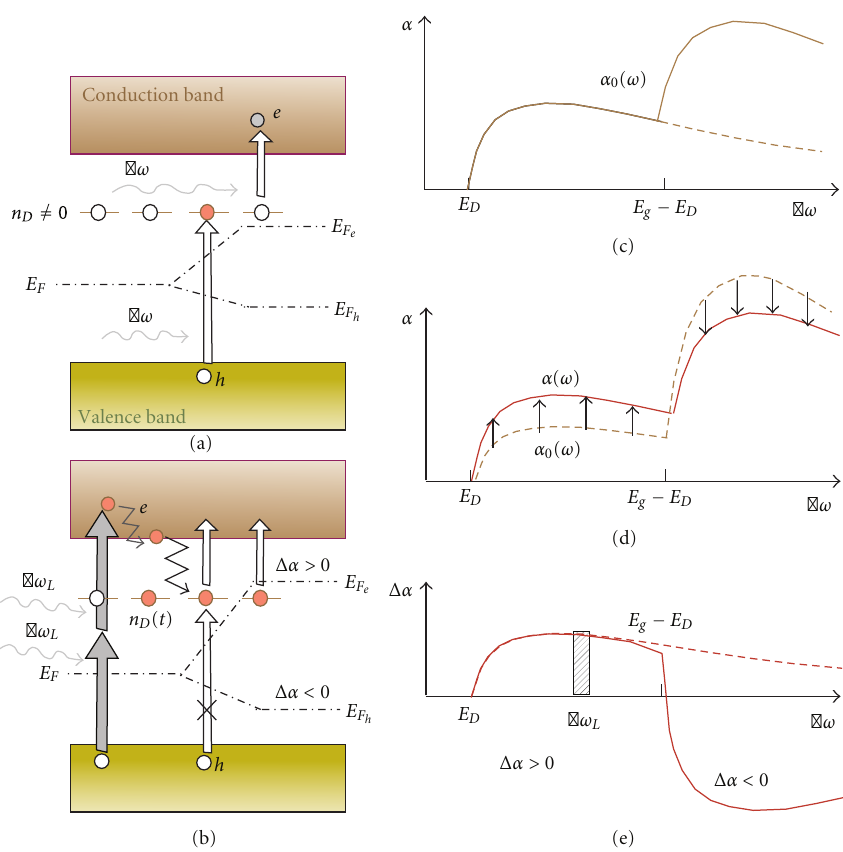
Figure 9: Schemes of the spectra formation for stationary α ( ω ) and induced Δ α ( ω ) impurity absorption and the optical transitions, explaining γ -DLSS, as the consequence of laser modulation of the quasistationary TSA by the capture of two-photon generated carriers. (a) and (c). Energy scheme and TSA spectrum α ( ω ) before the modulation [same as on (b) and (e) parts of Figure 4]. (b) and (d). Energy scheme and TSA spectra changes as a result of laser modulation. (e) Resultant induced absorption spectrum.